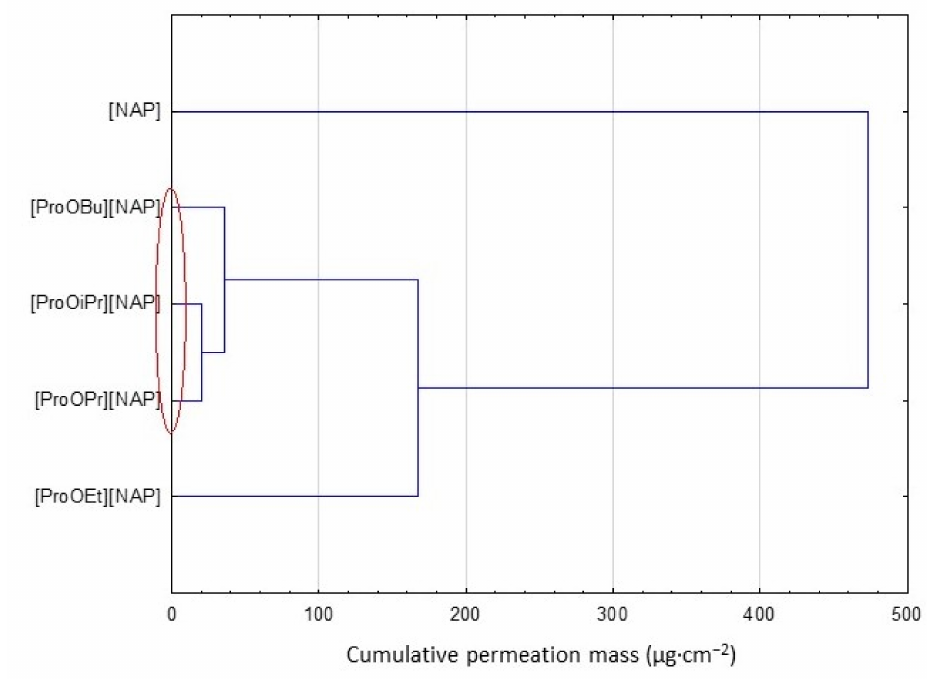
Figure 11. Cluster analysis graph for the mean accumulated mass of naproxen and its derivatives during the entire 24 h study. Compounds with similar values are marked with a red